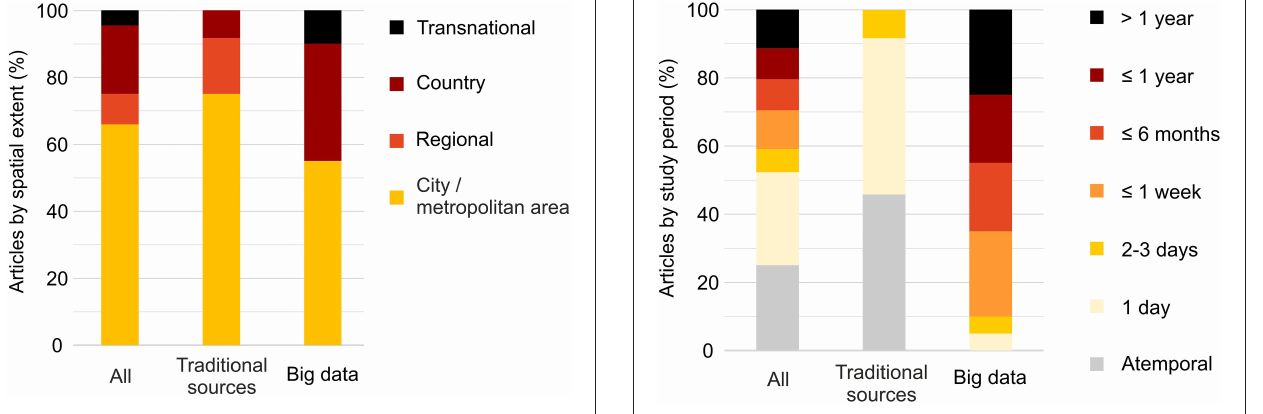
FIGURE 8 | Distribution of articles by the length of the study period of all activity space segregation studies ( n = 44), and separately of studies using traditional data sources ( n = 24) and big data sources ( n =